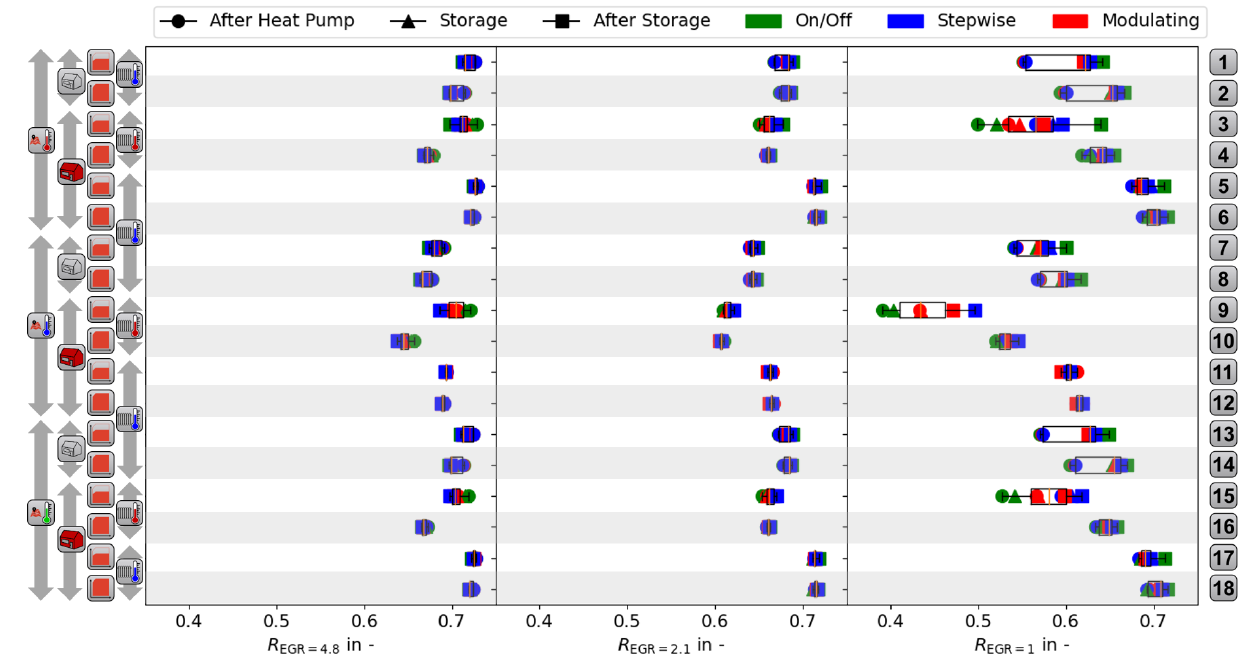
Figure A1. Boxplots for all conducted studies regarding saving potential, heat pump on/off switches, and backup-heater usage.